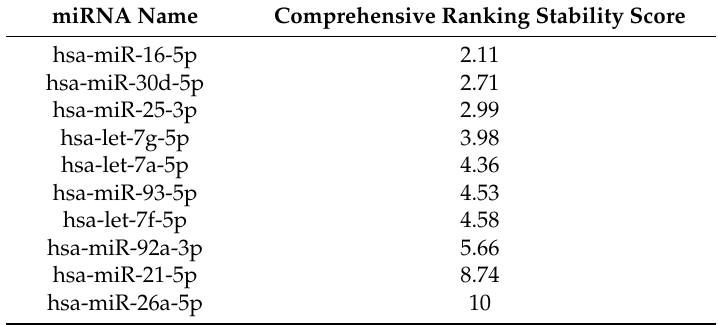
Table 4. RefFinder comprehensive ranking score of miRNA expression stability.